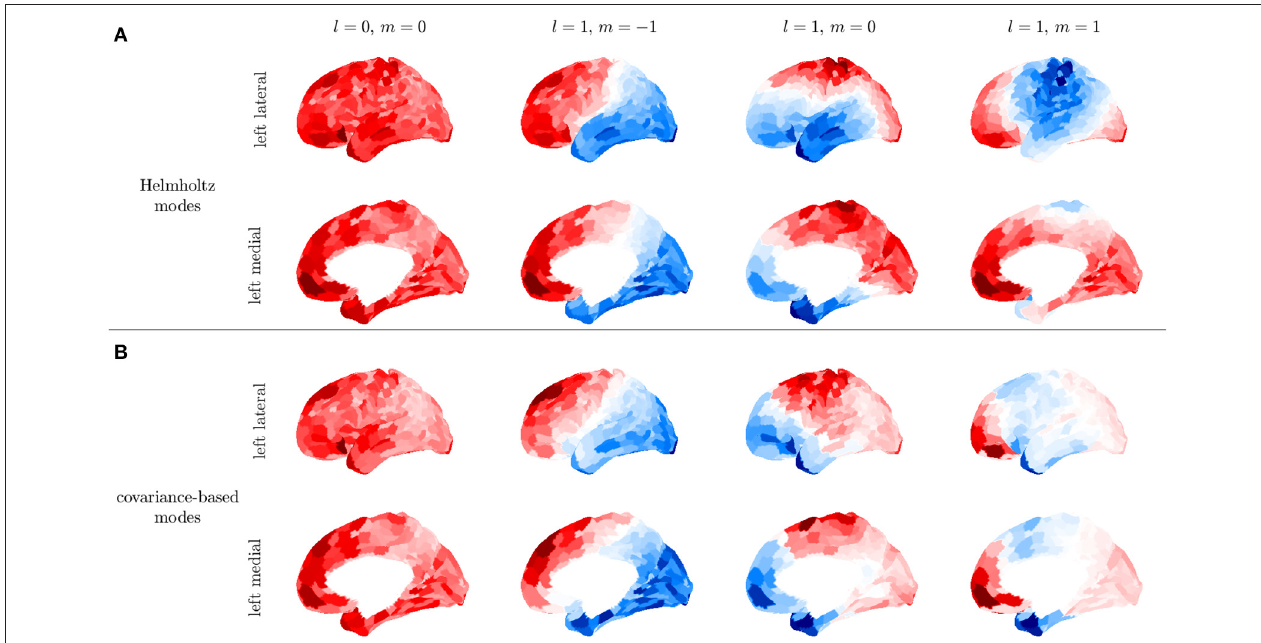
FIGURE 11 | First four modes for the left hemisphere. (A) Modes obtained by solving the Helmholtz equation on the cortical surface. (B) Covariance-based modes obtained from the average of C over subjects in the HCP1200 dataset; for each subject C was calculated for a 14 min